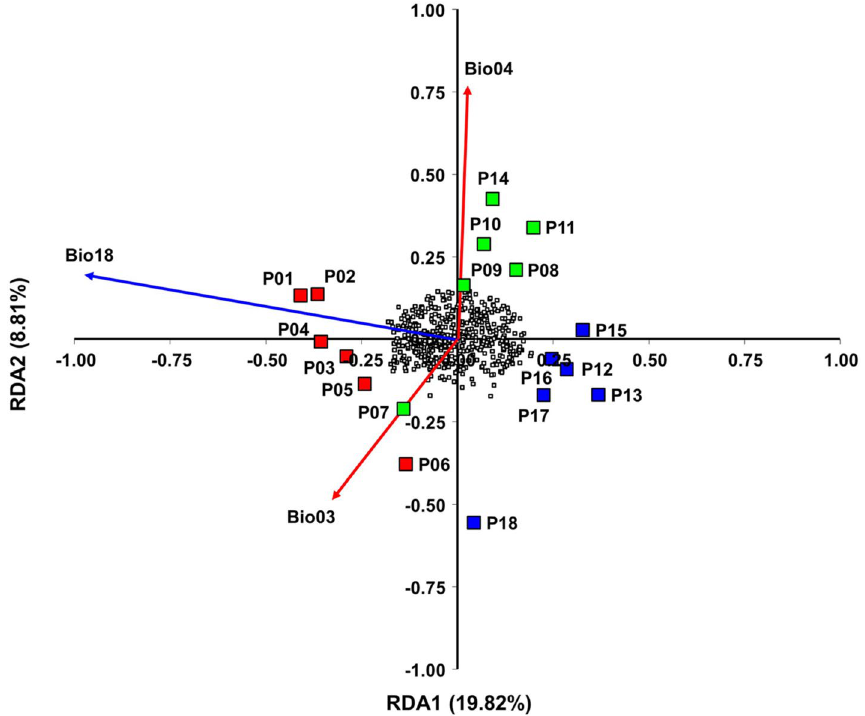
Figure 4. Triplot obtained by Redundancy analysis (RDA) based on three bioclimatic variables included in the optimal RDA model showing the relative contribution of bioclimatic variables in shaping the genetic structure of 18 H. italicum populations. Red vectors represent temperature-related variables (Bio3 and Bio04) and blue vector precipitation-related variable (Bio18). Northern Adriatic H. italicum populations (P01–P06) are colored in red, central populations in green (P07–P10) and southern populations (P11–P18) in blue color. Small empty boxes represent